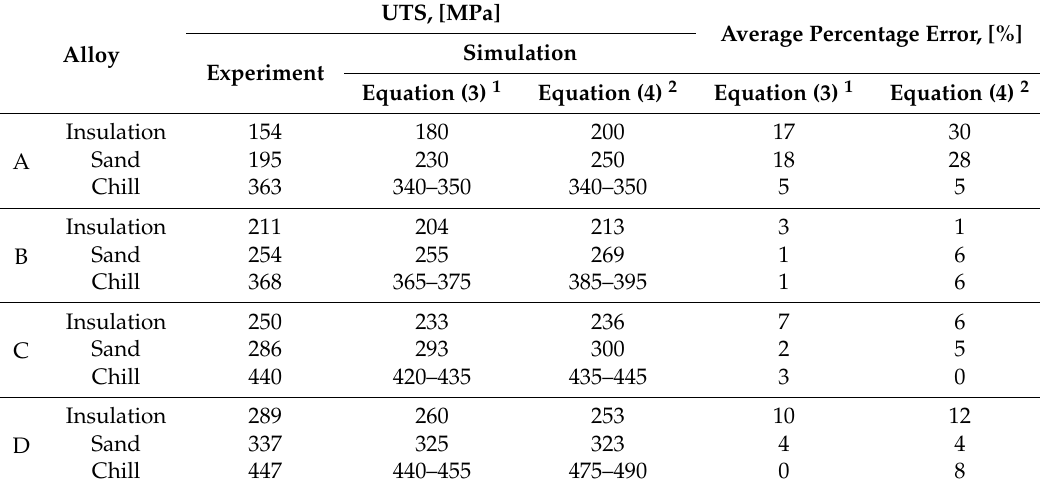
Table 3. Experimental and simulated UTS.